Question: Is the quantity shown trending increasing or decreasing?
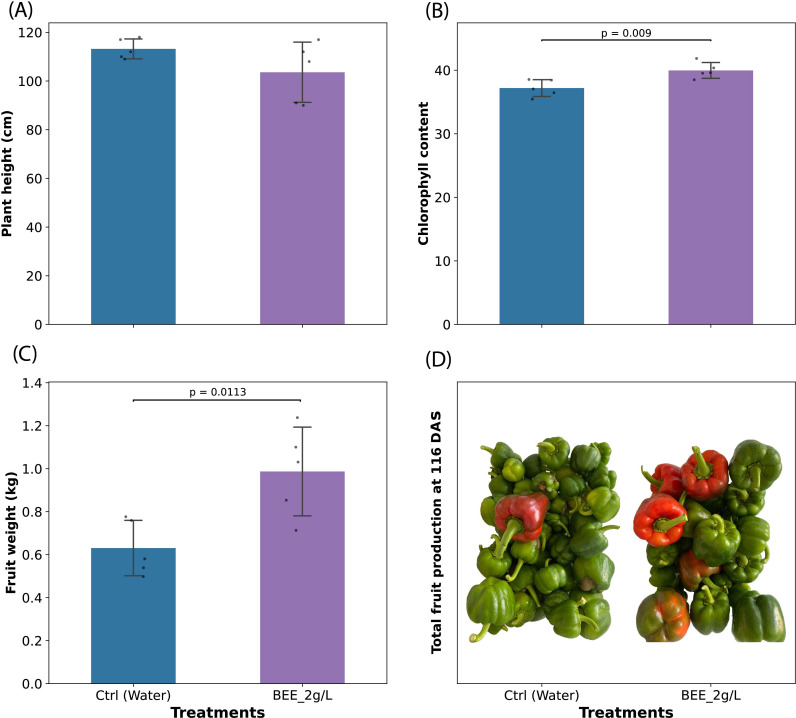
Answer: increasing